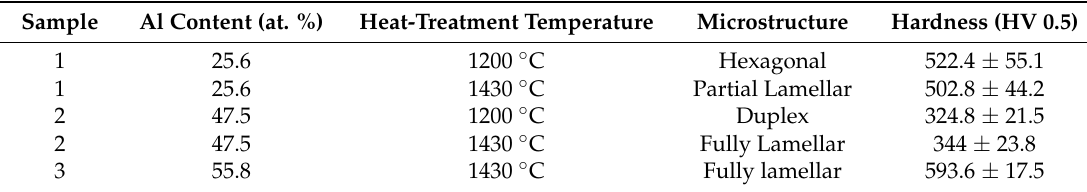
Table 2. Hardness results of titanium aluminide